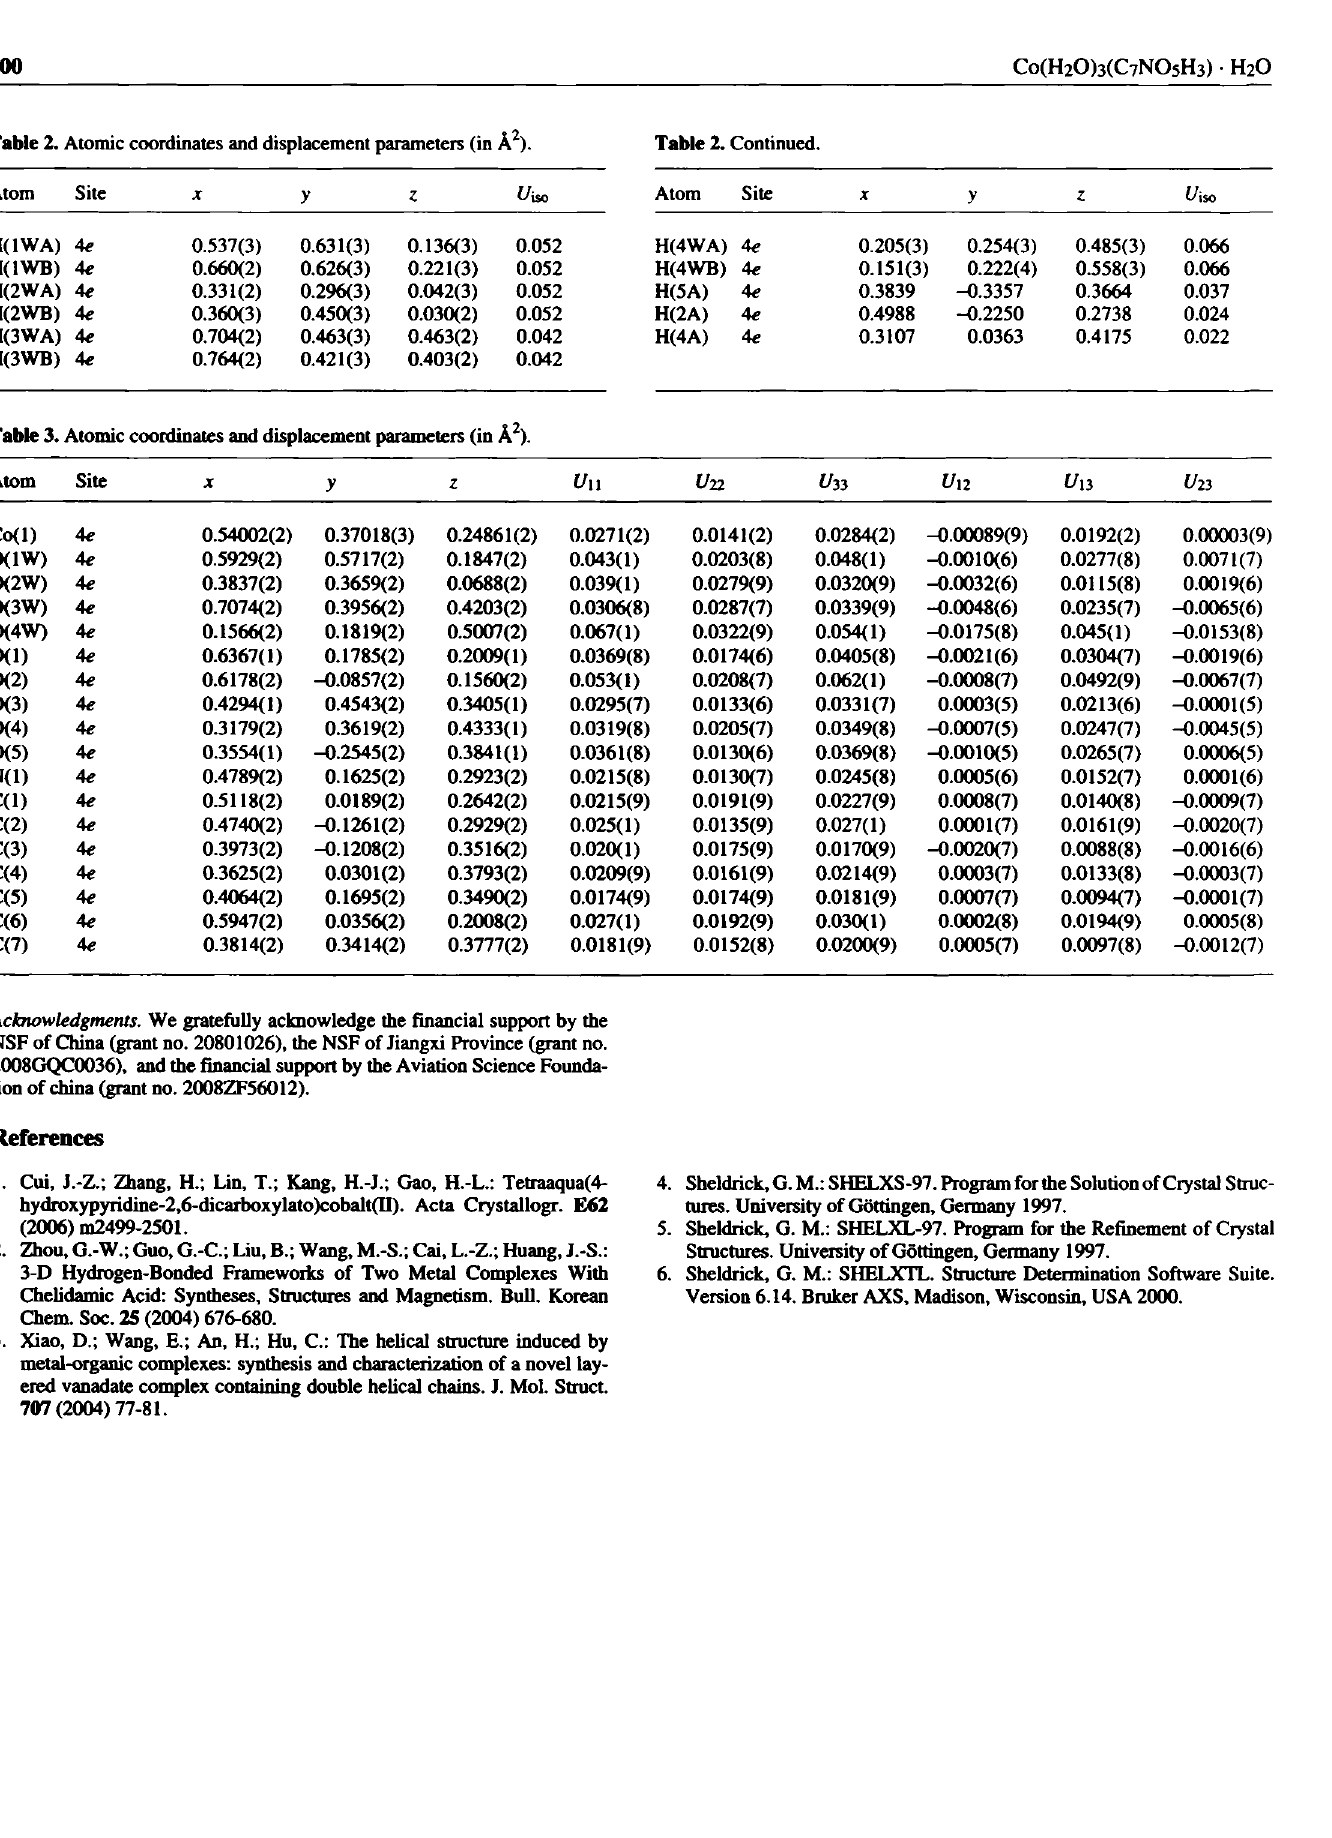
Table 2. Atomic coordinates and displacement parameters (in Â 2 ). Table 2. Continued.